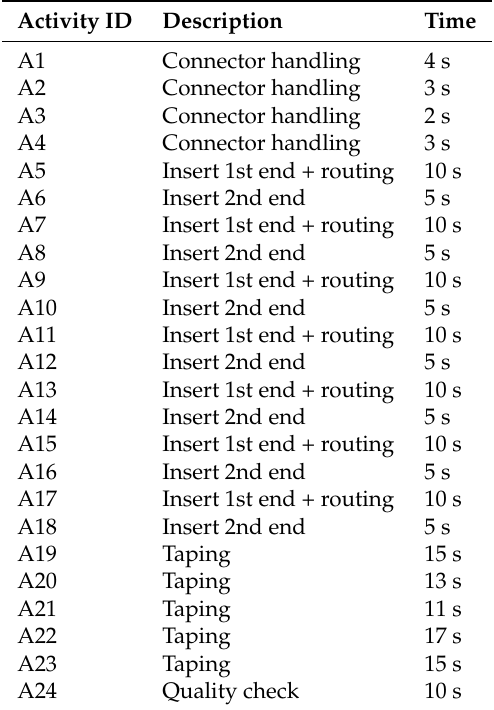
Table 2. List of the elementary activities that should be allocated in the line balancing problem.